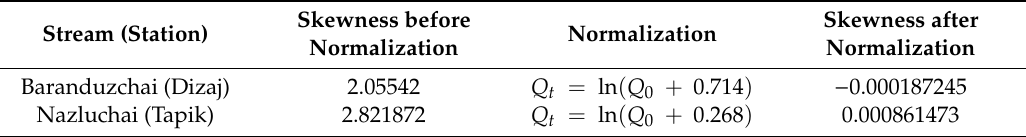
Table 3. Skewness and normalization equations for the studied streams.